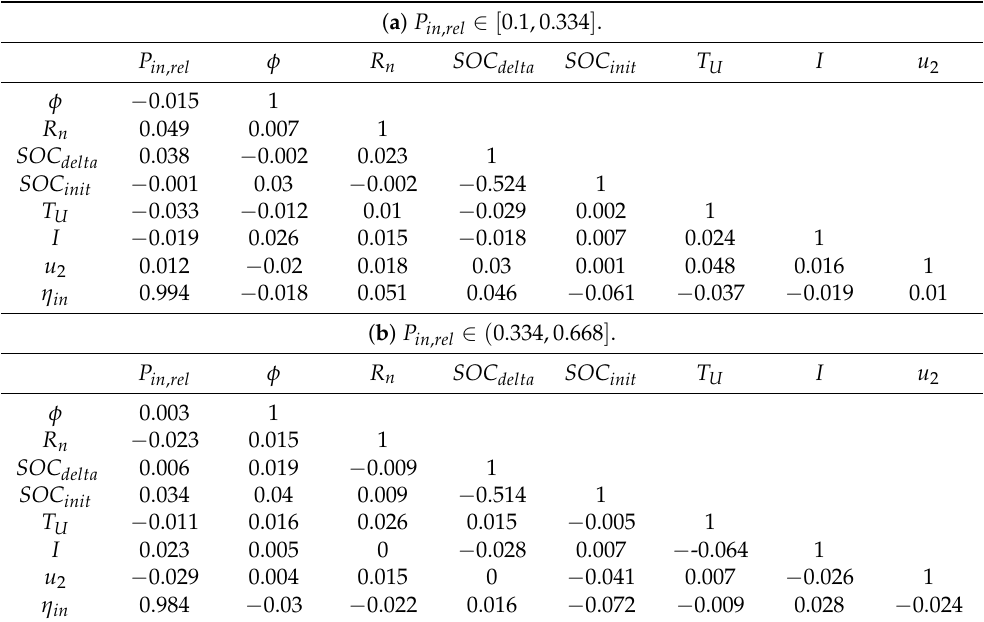
Table A1. Full Pearson Correlation Coefficient